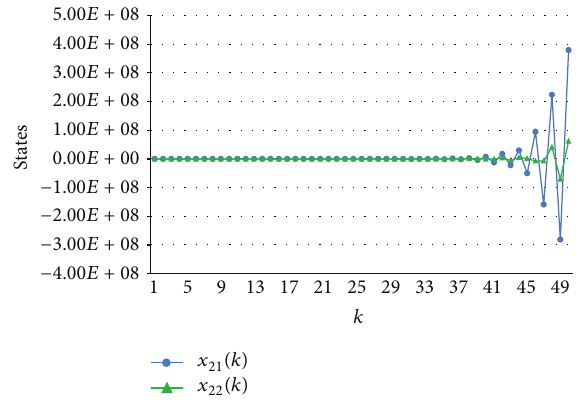
Figure 5: States respond of subsystem 2, 𝑥 21 (𝑘) and 𝑥 22 (𝑘) under feedback control, without discrete-time integral VSC.